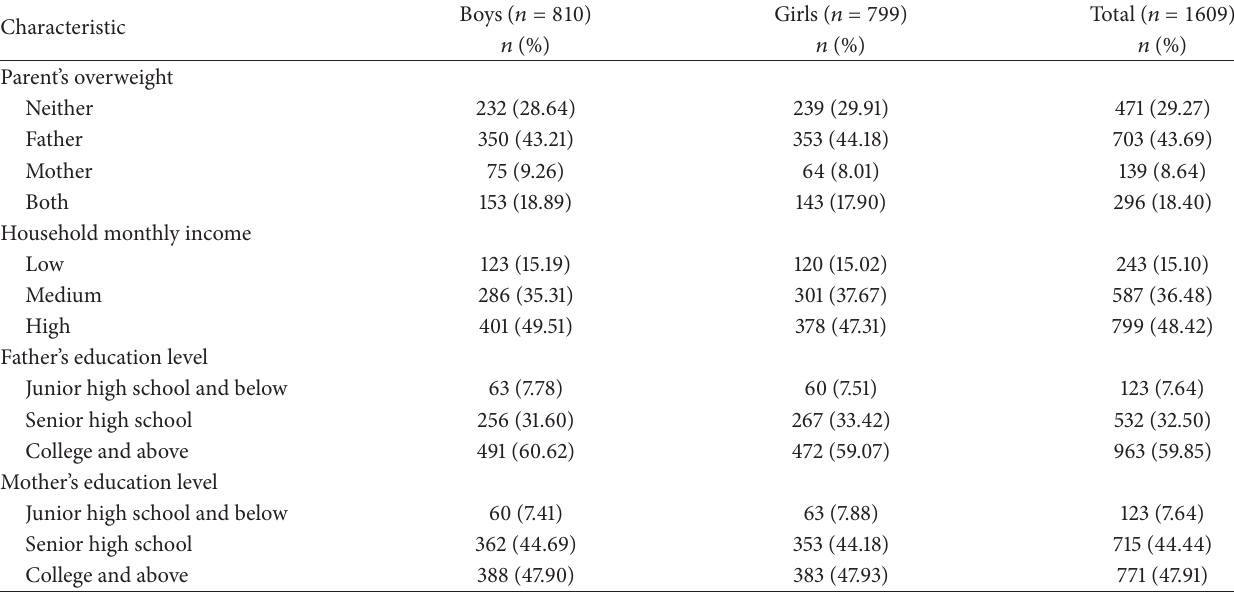
Table 1: Distribution of demographic characteristics in the study sample.